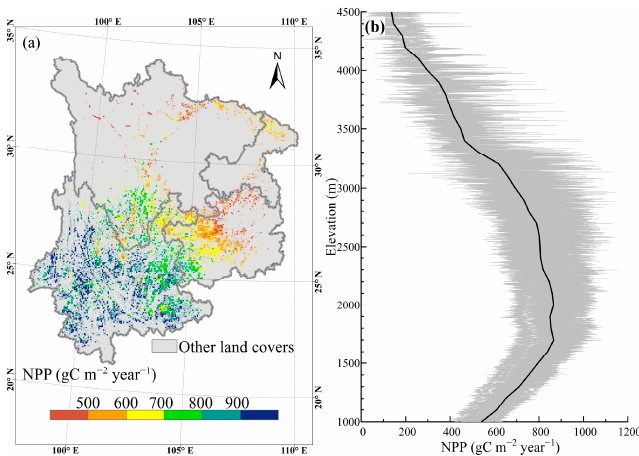
Figure 3. Spatial pattern ( a ) and elevational gradient ( b ) of mean annual cropland ecosystem NPP during 1981–2014.